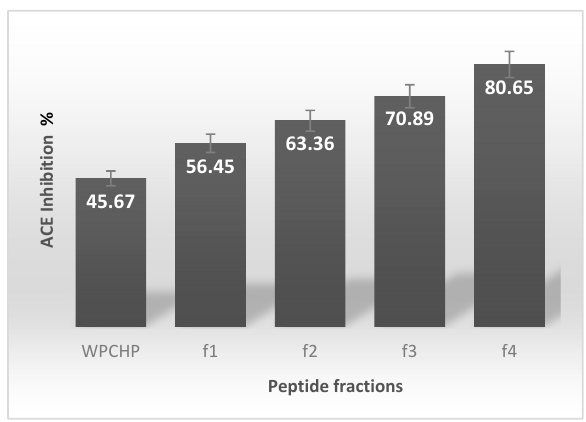
Figure 1. Angiotensin-Converting Enzyme inhibition % of whey protein concentrate hydrolysate permeate (WPCHP) and peptide fractions (f1–f4) from gel filtration chromatography. Fractions correspond as follows: f1, from 50 to 120 min; f2, from 120 to 180 min; f3, from 200 to 210 min; and f4, from 220 to 250 min. Values are expressed as the average ± SD of three independent determinations.